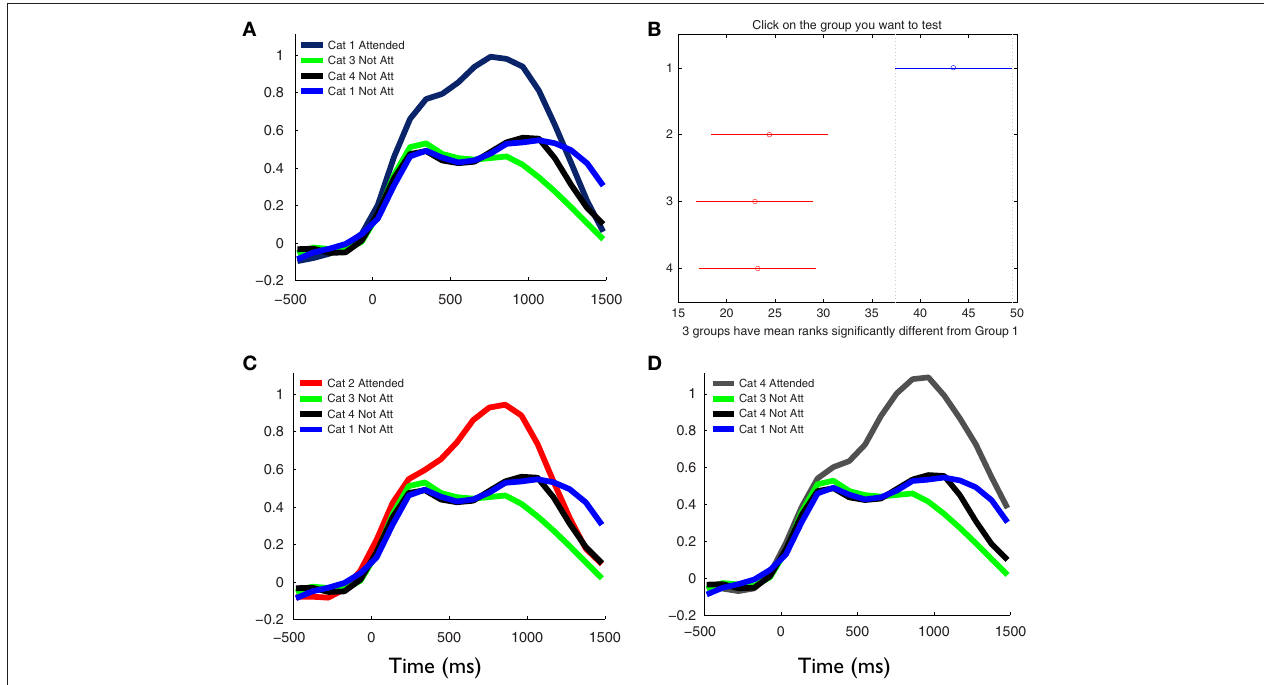
FIGURE 7 | Stronger phase synchronizations are dependent of the cognitive task and occur independently of the semantic material to be kept in mind. Temporal profile and statistical difference of the average phase synchronization changes during the second phase of the task, in the frequency range between 1 and 6Hz for each category. Each signal represents the average of the Z -score values across all valid pairs of electrodes and subject, during the task. (A) , (C) , and (D) show the comparison between the kept in mind category at each block of the task, respectively, and the same and other categories when not attended in all